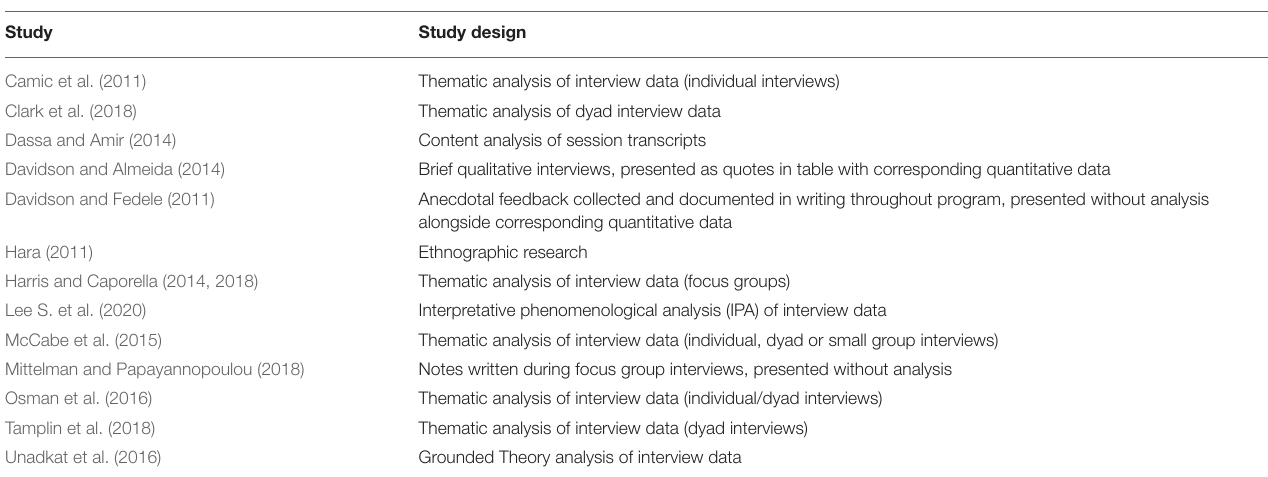
TABLE 9 | Summary of qualitative study